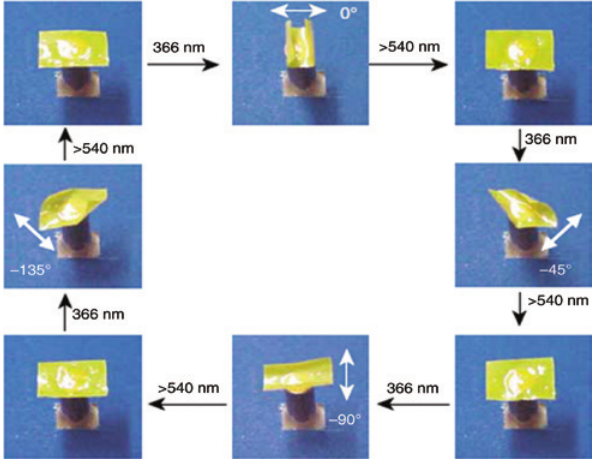
Figure 24: The polarization-dependent bending and unbending behavior of polydomain azo-LCE films. The bending direction is determined by the direction of the irradi- ated linearly polarized UV light. Adapted with permission from Ref. [324], copyright 2003, Spinger